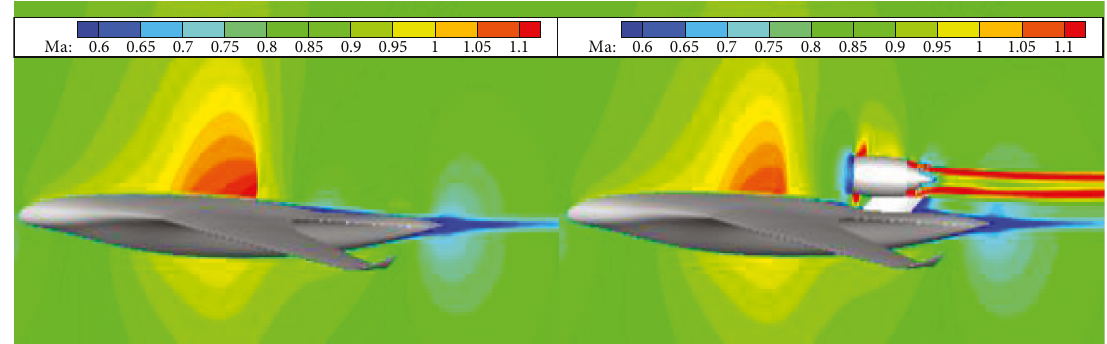
Figure 13: Whole model symmetric plane Mach number contour of the clean and powered con fi gurations at the cruise state.